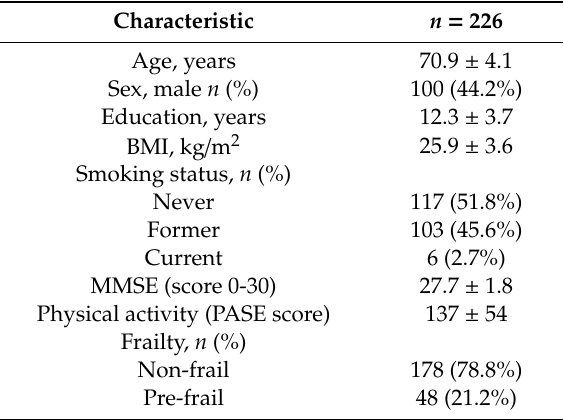
Table 1. Baseline characteristics of 226 healthy Dutch older